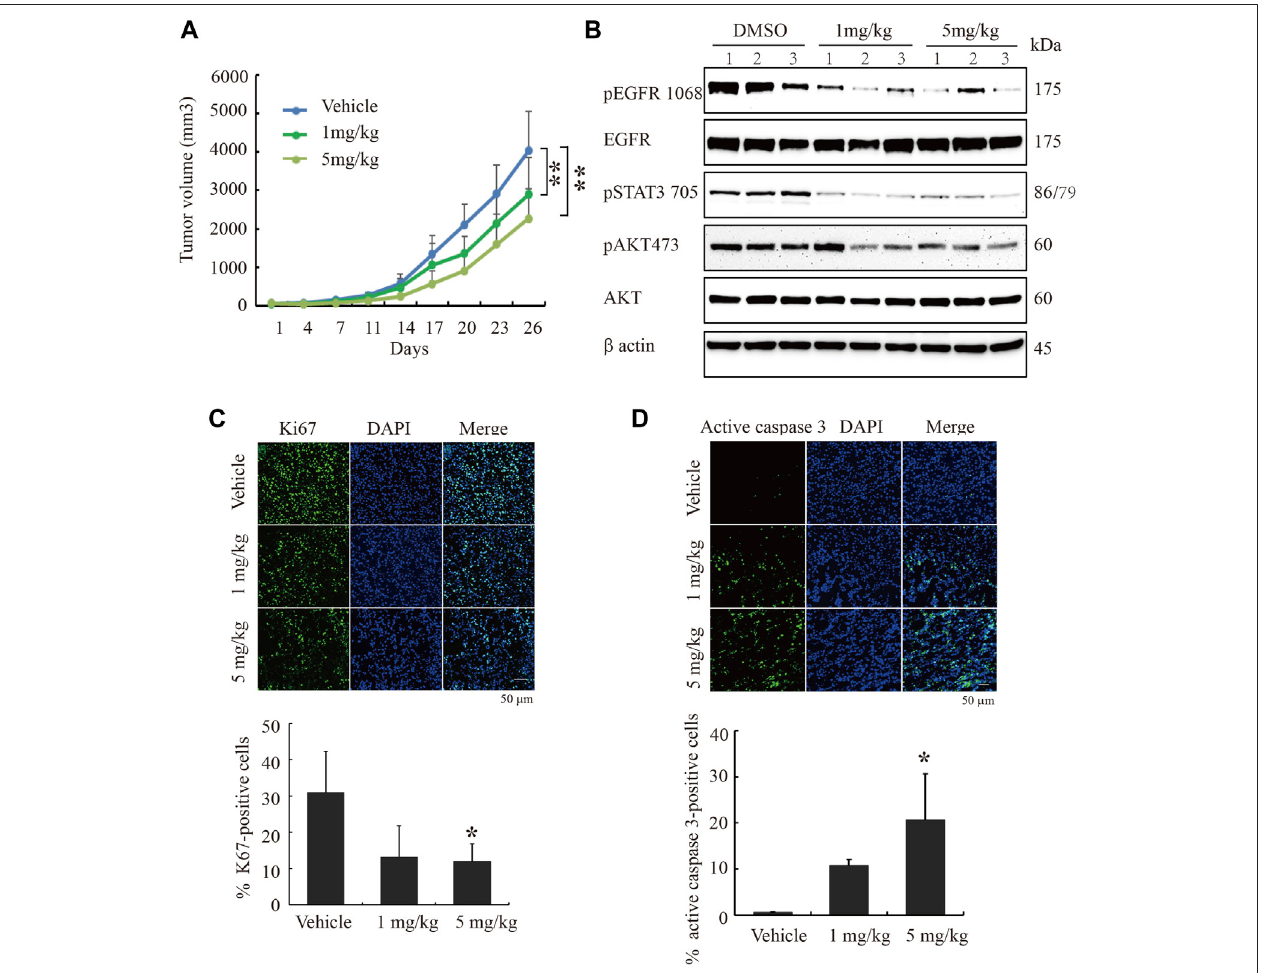
FIGURE 5 | Cinobufagin blocks subcutaneous tumor growth of U87MG-EGFR cells. (A) Cinobufagin signi fi cantly decreases the tumor volumes in subcutaneous U87MG-EGFRxenograftmodel.U87MG-EGFRcellsweresubcutaneouslyinoculatedintonudemice,andafterthetumorsformed, thenudemicewereintraperitoneally injected with vehicle (0.5% cyclodextrin) or cinobufagin at doses of 1 and 5 mg kg − 1 , respectively. Data represent means ± SD ( n (cid:2) 6/group). (B) Cinobufagin inhibits EGFR and STAT3 signaling in subcutaneous tumors. The tumor tissue lysates from vehicle- or drug-treated samples were analyzed by Western blotting with the indicated antibodies. (C,D) Cinobufagin inhibits cell proliferation and induces apoptosis in subcutaneous tumors. The immuno fl uorescence staining of Ki67 and active caspase3ontumorsectionsderivedfromanimalstreatedwithorwithoutcinobufagin.Quanti fi cationofKi67andactivecaspase3 – positivecellsinsubcutaneoustumor. Data represent means ± SD. * p < 0.05; ** p <